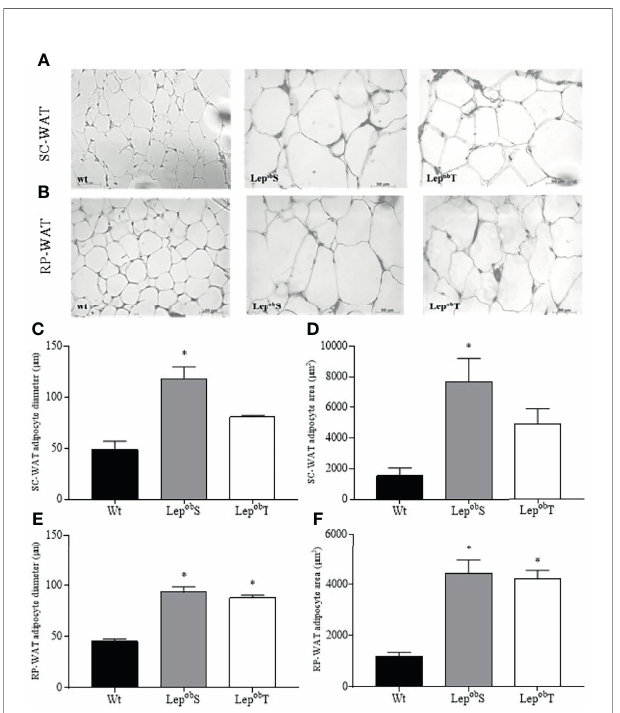
FIGURE 2 | Representative histological sections of SC-WAT (A) and RP-WAT (B) to visualize the morphology of adipocytes at 400X magni fi cation, SC-WAT adipocyte diameter (C) , SC-WAT adipocyte area (D) , RP-WAT adipocyte diameter (E) , RP-WAT adipocyte area (F) . Wt (n = 5), Lep ob S (n = 4) and Lep ob T (n = 4). Error bars indicate the SEM. *p ≤ 0.05 vs. Wt. The results were compared by the one-way ANOVA plus Tuckey post hoc test.